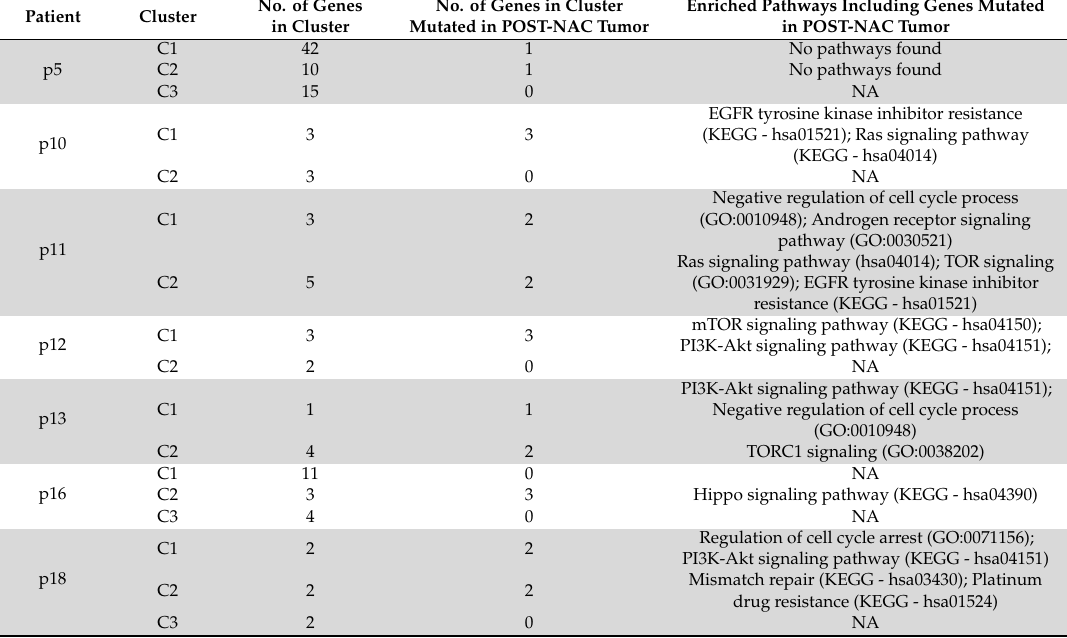
Table 2. Pathway enrichment analysis of mutations in patients with changed mutational profile between pre- and post-NAC samples.